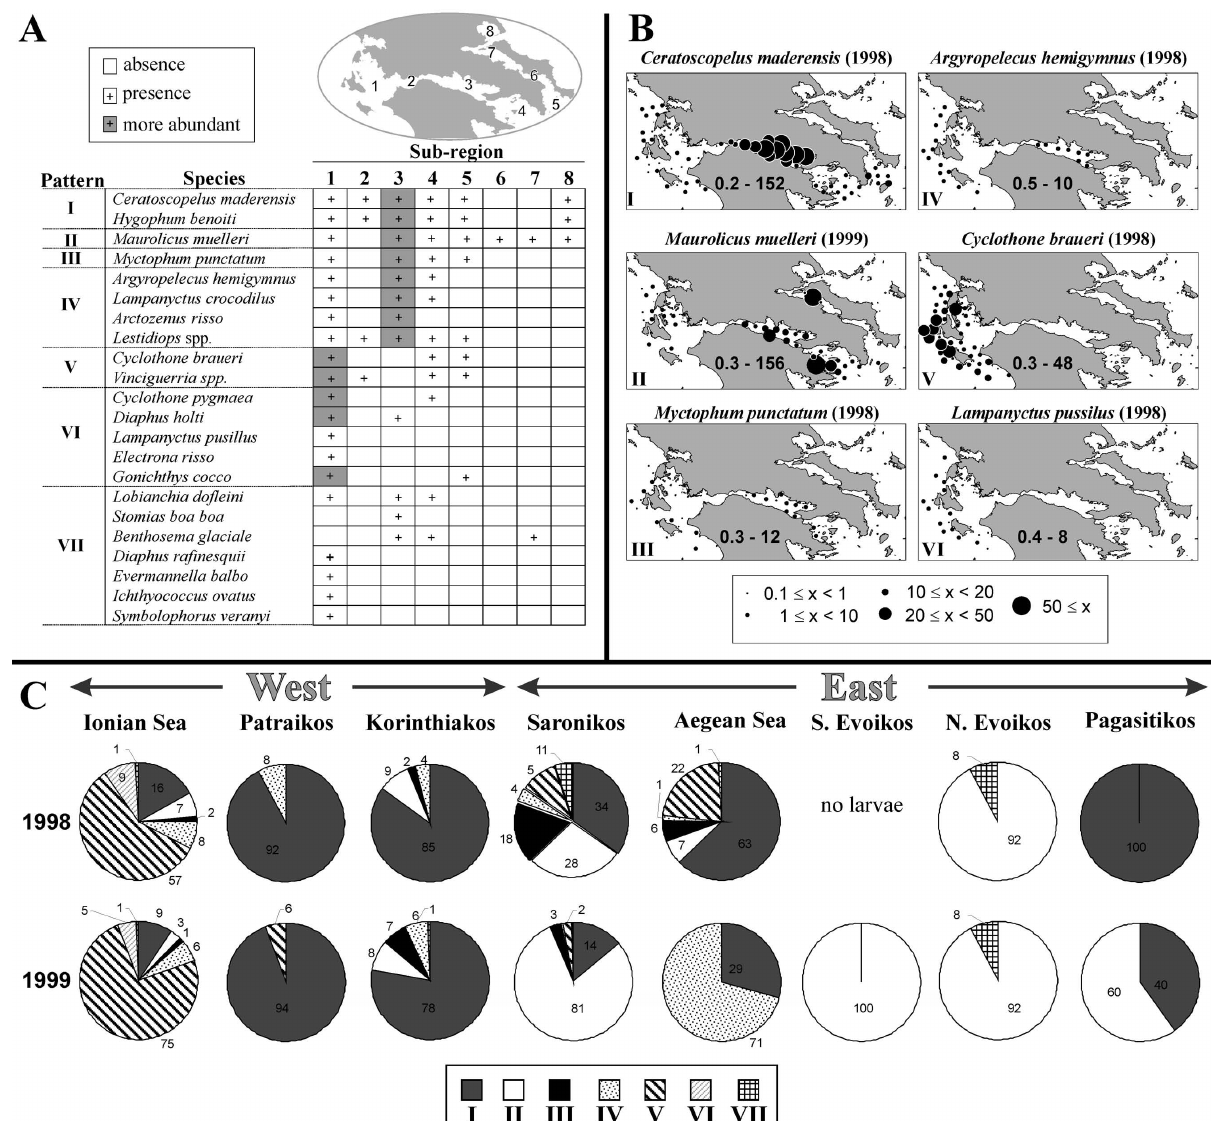
Fig . 6. – Larvae of mesopelagic species. (A) Distribution patterns (I-VII) exhibited by the mesopelagic taxa in both surveys. The taxa were assigned to patterns on the basis of their presence and relative abundance in each sub-region. (B) Distribution and abundance of larvae (ind m -2 ) of selected taxa in 1998 exemplifying distribution patterns I-VI. The respective range of abundance values (positive stations) is given in each map. (C) The percentage contribution to the mesopelagic assemblage structure of taxa with distribution patterns I-VII in each sub-region and